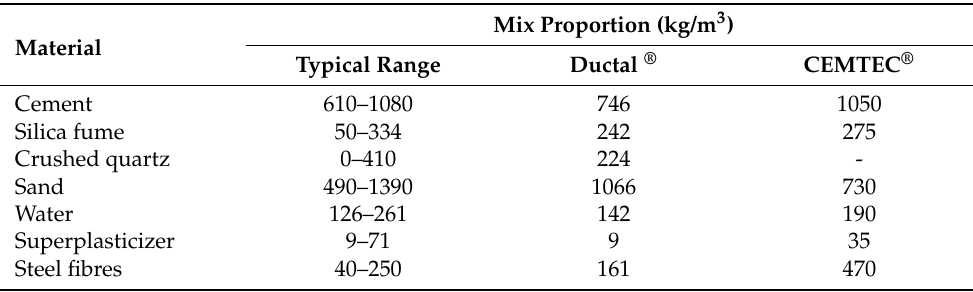
Table 1. UHPFRC typical mix design proportion range and mix proportions of commercial UHPFRC products [Adopted from Refs.